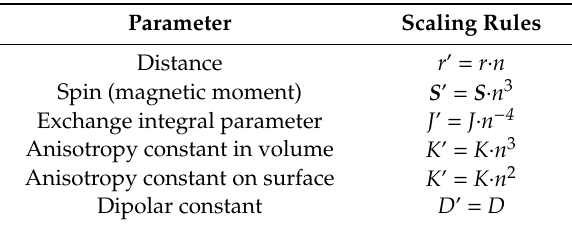
Table 1. Summary of the scaling